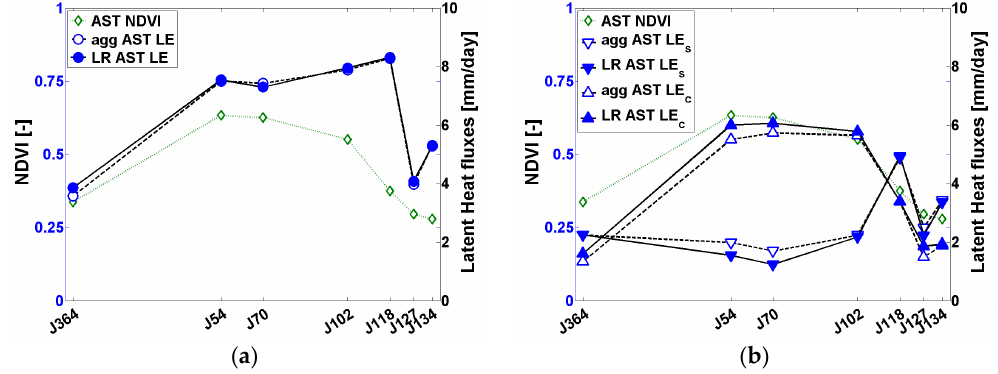
Figure 6. ( a ) ‘agg-ASTER’ and ‘LR-ASTER’ TSEB latent heat fluxes time series; ( b ) partition between evaporation LE s and transpiration LE v